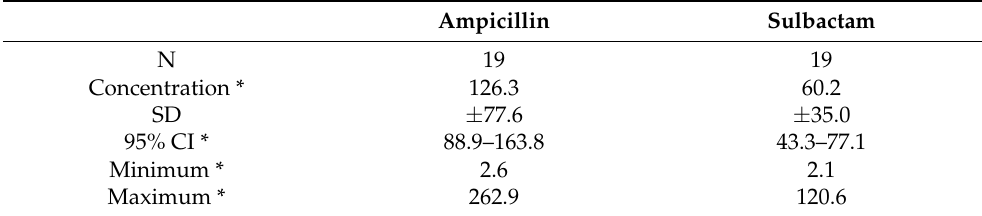
Table 2. Concentrations of ampicillin and sulbactam in plasma.